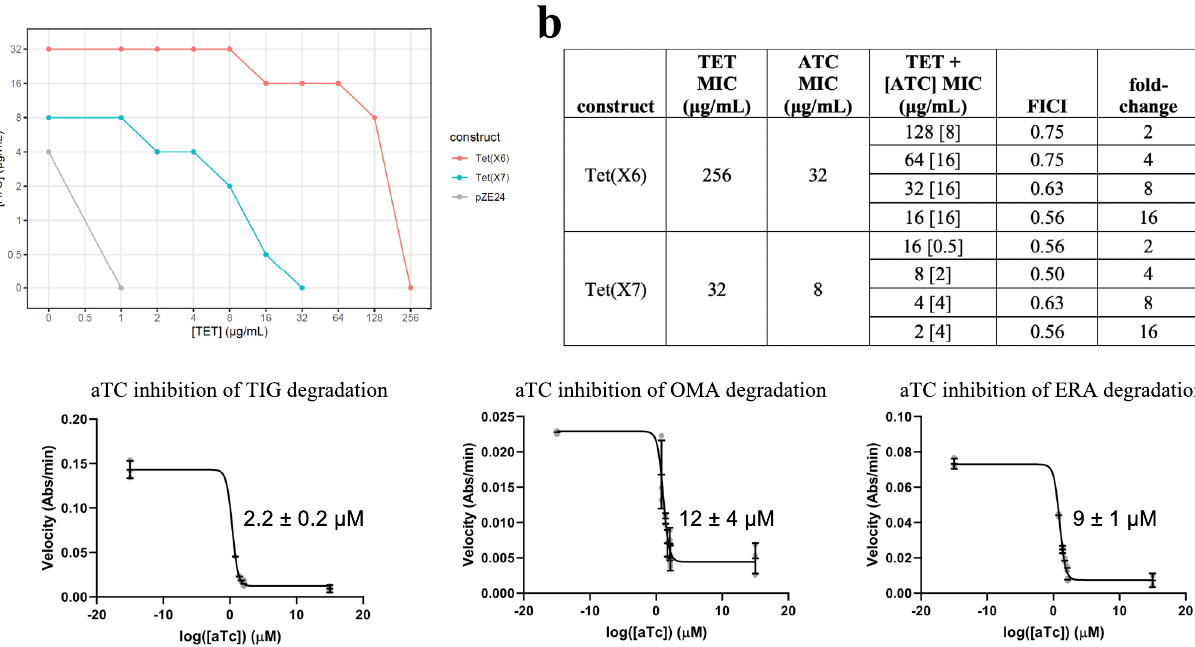
Fig. 3 Anhydrotetracycline rescues Tet(X6)-mediated inactivation of tetracycline antibiotics. a Whole cell inhibition of E. coli expressing tetracycline destructase enzymes. Abbreviations: tetracycline (TET); anhydrotetracycline (aTC). b Calculated FICI. c In vitro aTC inhibition of Tet(X6) degradation of tetracycline antibiotics as observed via an optical absorbance assay. IC 50 values of each curve are shown. Error values represent standard deviations for three independent trials.